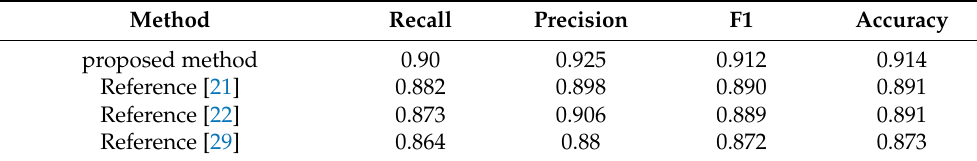
Table 2. Test results of the